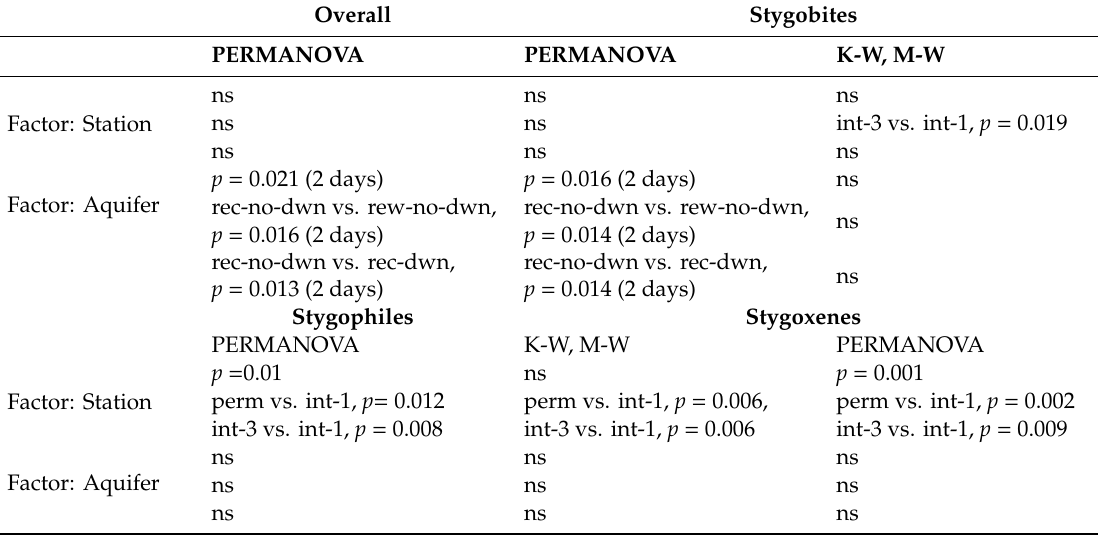
Table 2. Results of PERMANOVAs (for factor aquifer phase, only the relevant comparisons are shown, i.e., same phase with and without downwelling, and di ff erent phase with / without downwelling). Factor aquifer tested for intermittent sites. 2 days: time interval used for calculation of the hydrological phases. Only significant results are shown. K-W: Kruskall–Wallis test; M-W: Mann–Whitney test; ns: not significant. Station codes as in Figure 2, aquifer codes as in Table